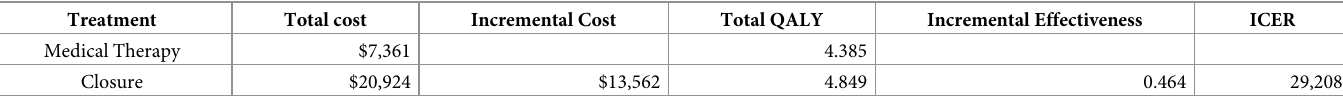
Table 2. Base case cost-effectiveness analysis.